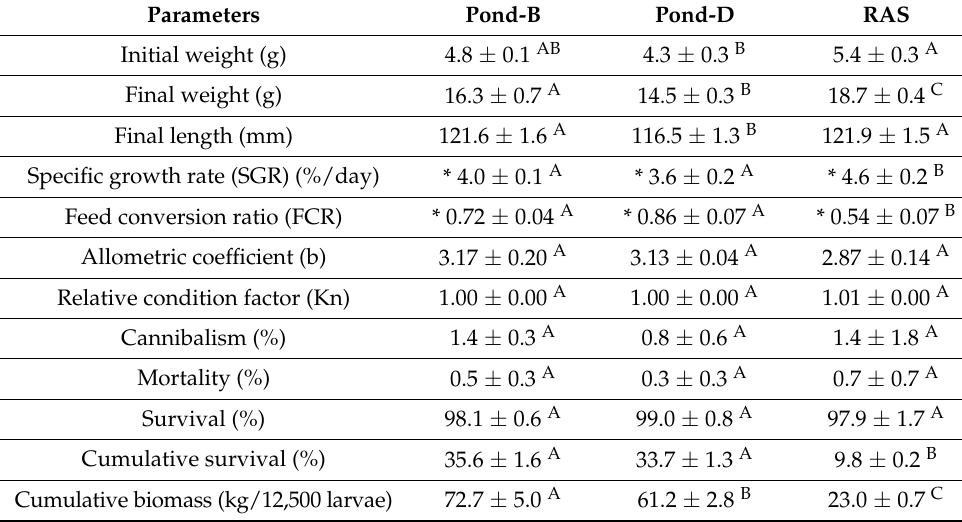
Table 4. Survival and morphometry of pond and RAS produced pike-perch Sander lucioperca juveniles at the end of the on-growing period, 101 DPH (means ± S.D., n = 3 tanks). * ANCOVA estimated marginal means evaluated at the stocking density of 6.8 g/L; results of post-hoc tests are provided as